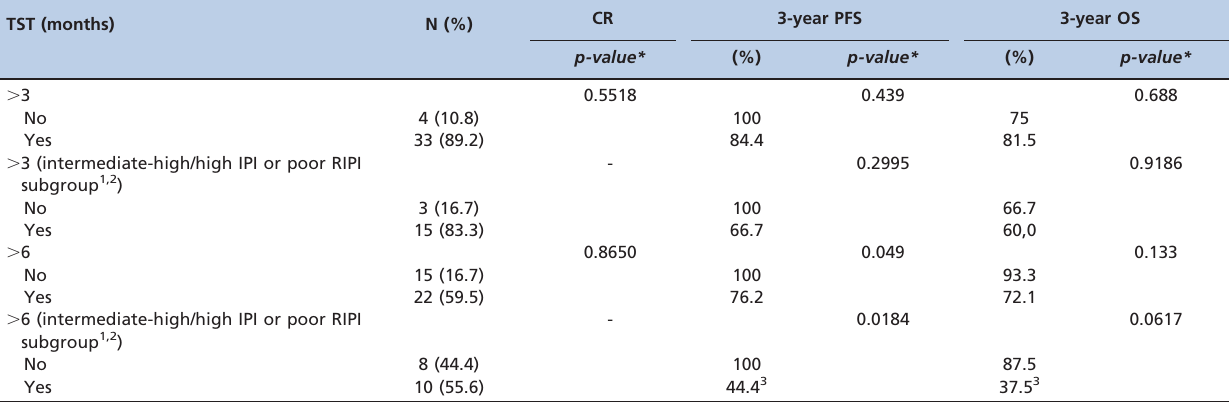
Table 2 - Correlation between time-to-treatment and treatment outcomes.